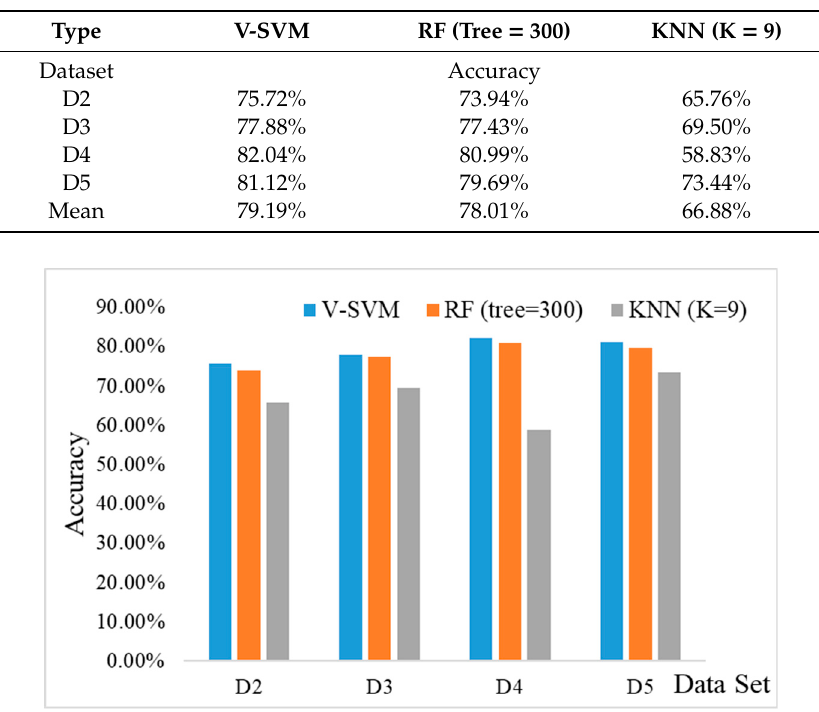
Figure 7. Comparison of the prediction results of three machine learning algorithms.